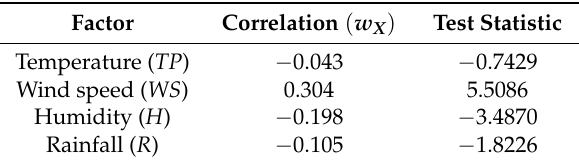
Table 2. Correlation between forest fire frequency and climate